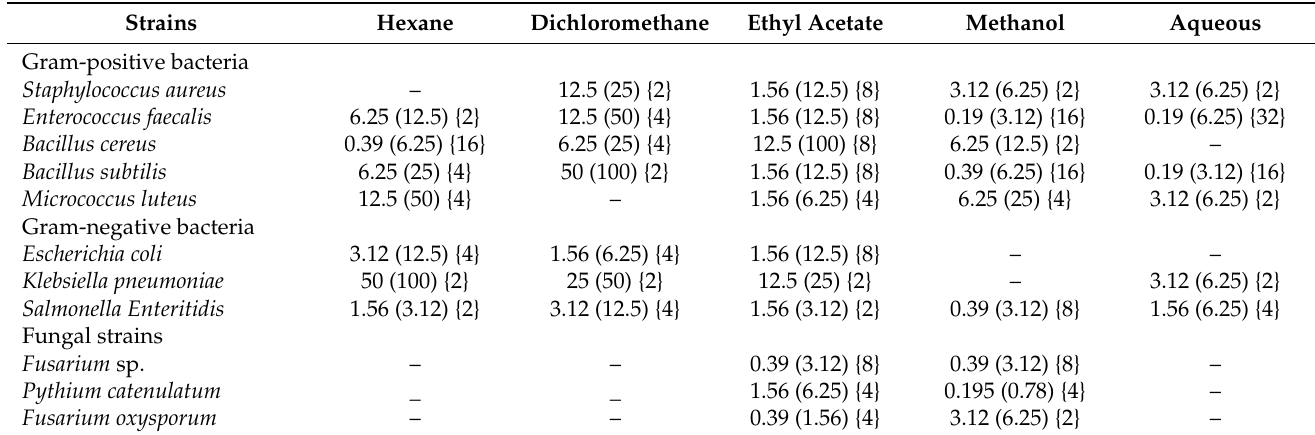
Table 2. Determination of MIC (MBC or MFC) in mg/mL and {MBC/MIC or MFC/MIC} of E. humile extracts.